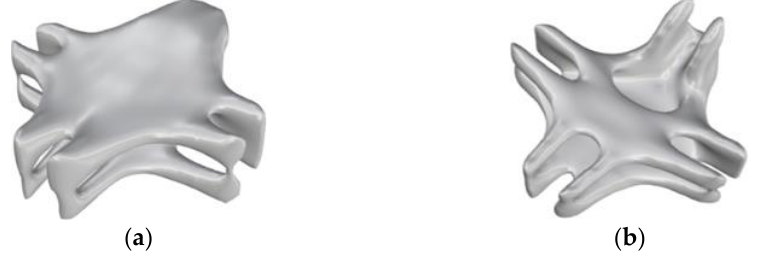
Figure 19. Smooth model of different angles under combined working conditions: ( a ) top; ( b ) bottom. All the jagged boundaries of the model were smoothed, and the model was in a printable state as a